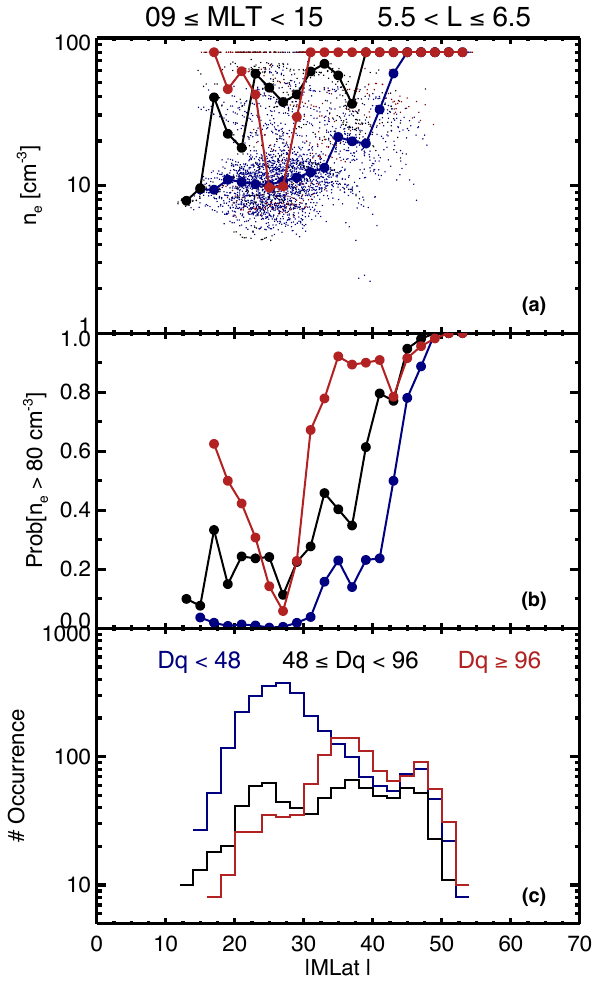
Fig. 7. Distribution of electron density versus latitude (at a resolu- tion of 2 ◦ ), for magnetic flux tubes covering the 09:00–15:00MLT sector and crossing magnetic equator at 5 . 5 ≤ L < 6 . 5. Panel (a) displays the scatter plot of n e records (dots) and the correspond- ing median values (full circles). Panel (b) displays the probability of observing densities greater than 80cm − 3 and panel (c) shows occurrence numbers. For all panels, the three curves depict prop- erties of n e for a duration of quiet activity being Dq < 48 (blue), 48 ≤ Dq < 96 (black) and Dq ≥ 96 (red), as defined in the text.